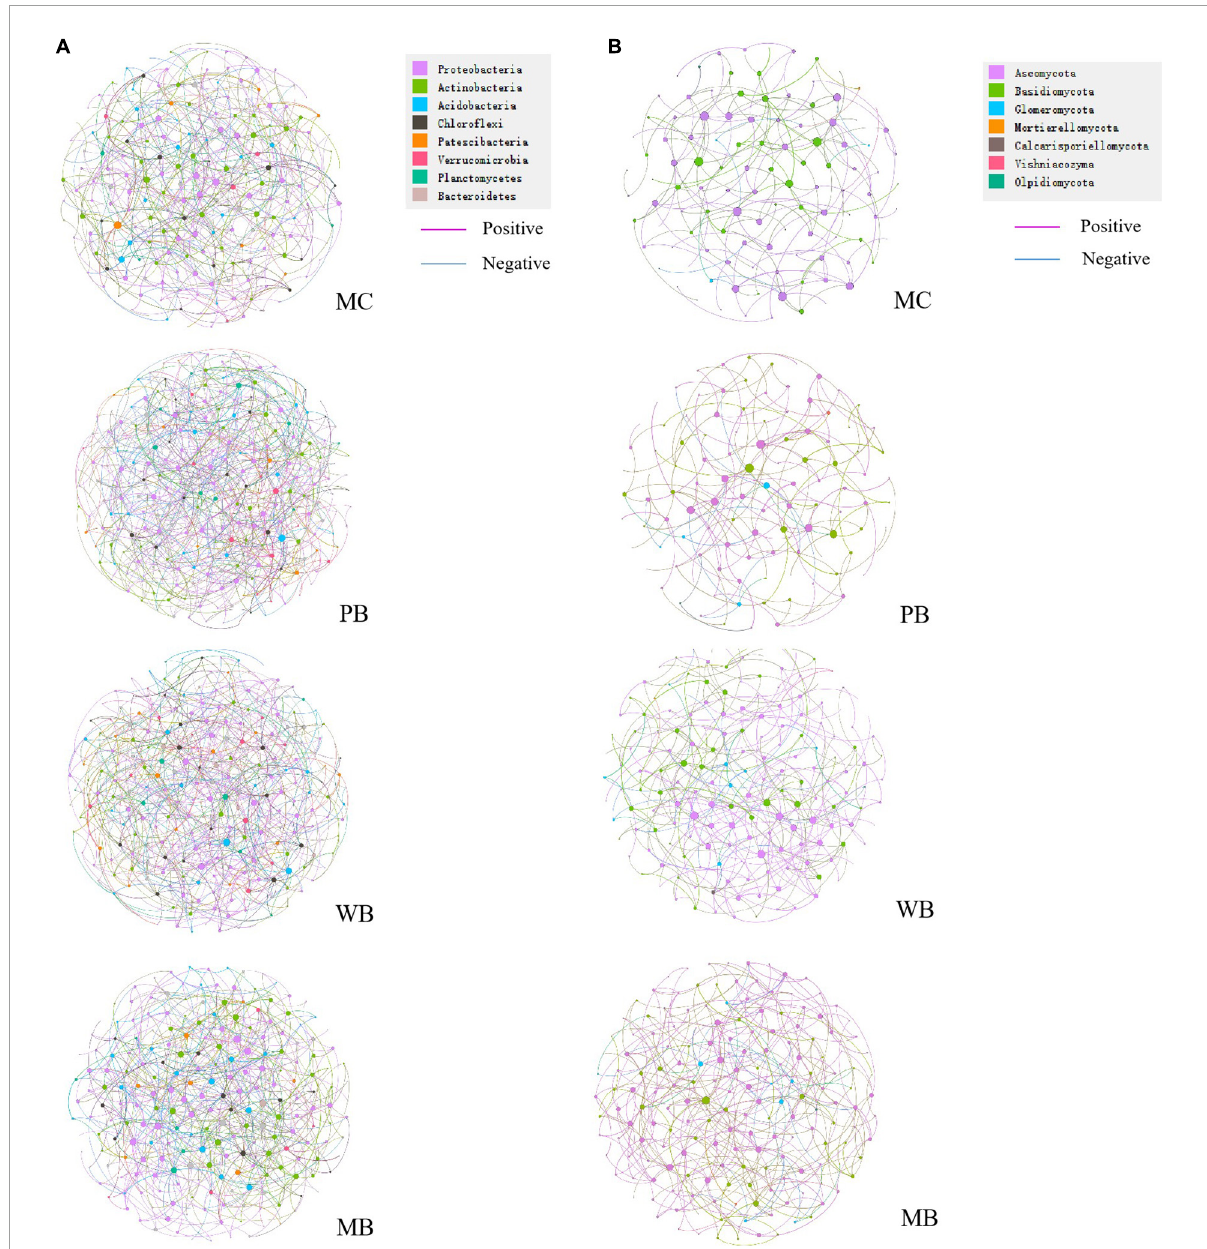
FIGURE6 Bacteria > (A) and fungal (B) co-occurrence networks colored by their phyla, based on Spearman’s correlations, of rhizosphere soil sampled on 3-year following amendment at 20 t ha − 1 . The size of each node is proportional to the number of connections (degree), and the thickness of each edge is proportional to the value of Spearman’s correlation coefficients. The red edges denote negative interactions while blue edges positive interactions, between two nodes. MC, amendment of manure compost at 20 t ha − 1 ; PB, WB, and MB, amendment of wood, maize, and pig manure biochar at 20 t ha − 1